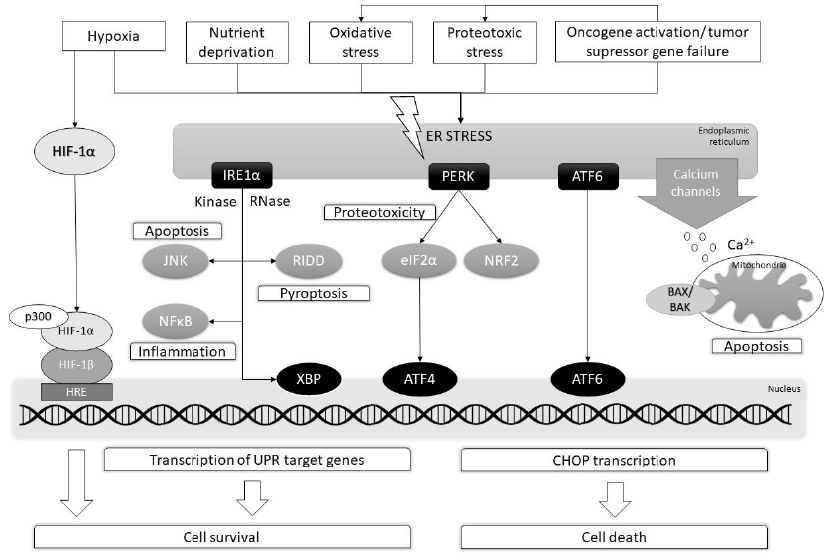
Figure 1. The possible fates of cellular regulation mechanisms under ER stress in MPNST. Various internal and external factors can cause ER stress and concomitant accumulation of unfolded proteins followed by UPR induction. In MPNST cells, ER stress level is elevated (in comparison with normal cells), but at the moderate level, it induces a cascade of IRE1α/PERK/ATF6 signaling pathways to promote cell survival and avoidance of apoptosis. Moreover, HIF-1 is constantly overexpressed in MPNST cells, and its stabilization by hypoxic conditions promotes cell survival and tumor angiogenesis. Currently, one of most interesting therapeutic targets for MPNST are factors that can induce terminal ER stress. Together with Ca 2+ dysregulation, it can lead to the mitochondrial release of apoptogenic factors that activate caspase-induced apoptosis. Moreover, pro-apoptotic BAX/BAK complex enhances Ca 2+ release at the ER and mitochondria. When hyperactivated, PERK- and IRE1α-mediated signaling pathways promote inflammation, proteotoxicity as well as pyroptosis and apoptosis. Finally, terminal ER stress signaling induces the transcription of pro-apoptotic factor CHOP.